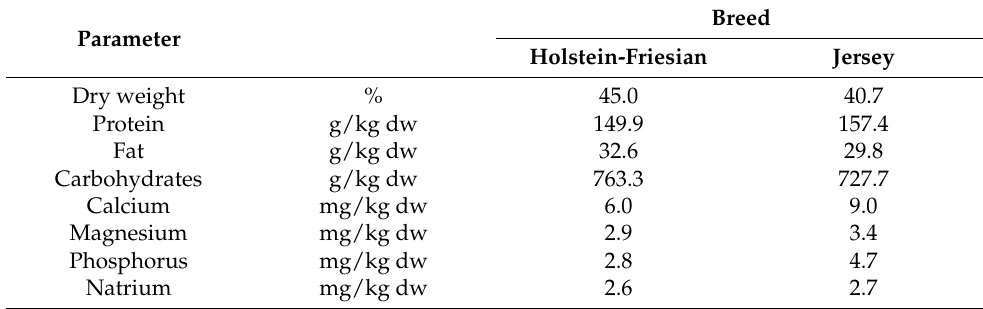
Table 1. Nutritional composition of